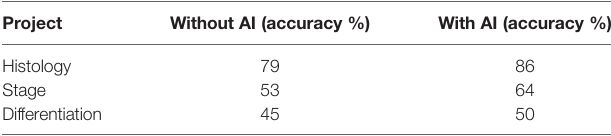
TABLE 2 | Comparison of doctors ’ predictions with and without AI assistance.